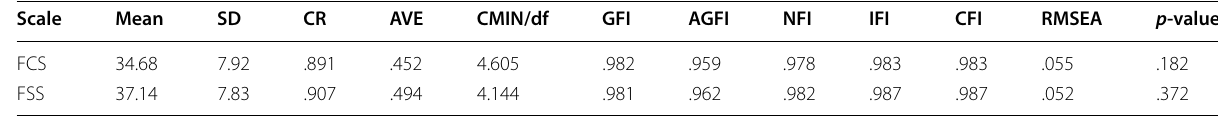
Table 5 Descriptive statistics (total score), AVE, CR, and the main fit indices for the FCS and the FSS scales Scale